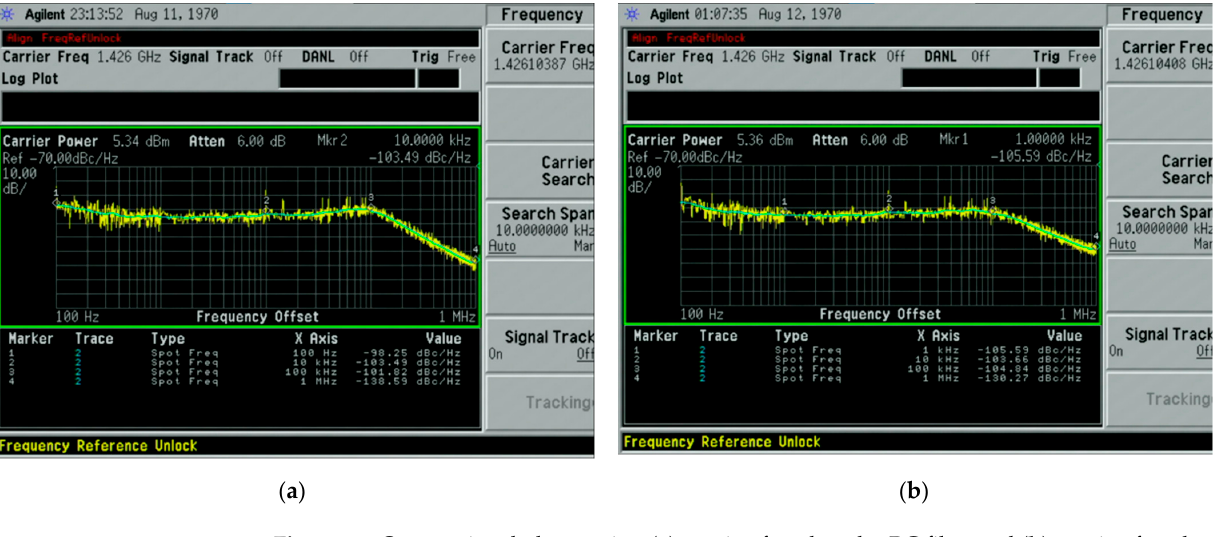
Figure 10. Output signal phase noise: ( a ) passive fourth-order RC filter and ( b ) passive fourth-order RLC filter.